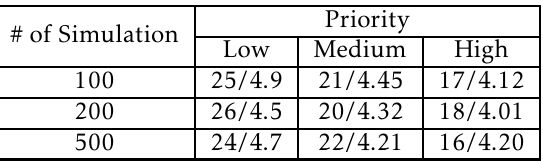
Table 3. Mean and std. of the number of channel switching with different priorities in 10